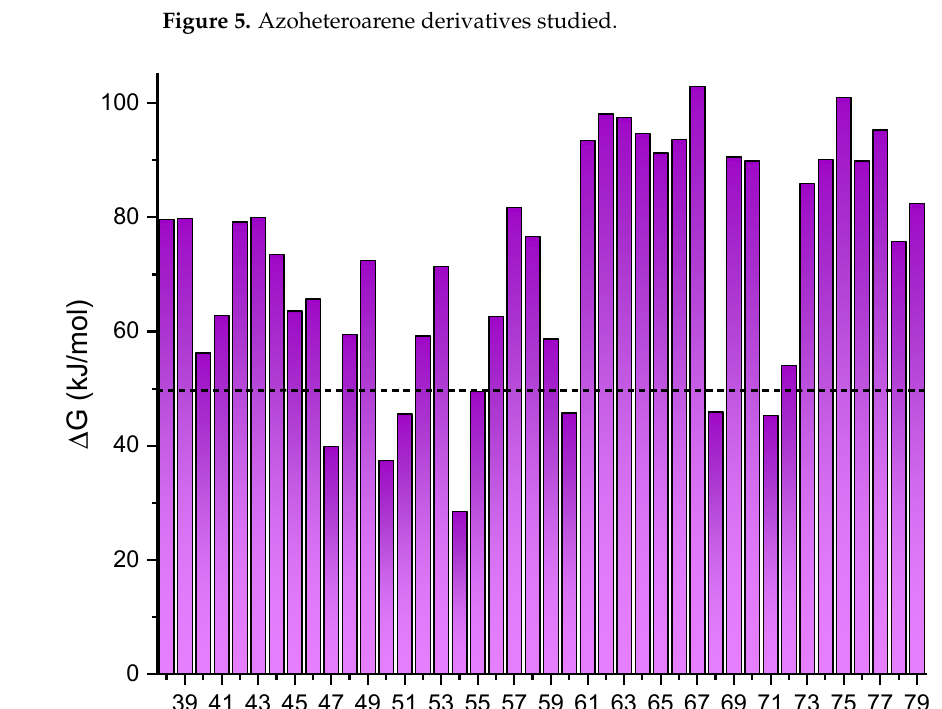
Figure 5 . Azoheteroarene derivatives studied.